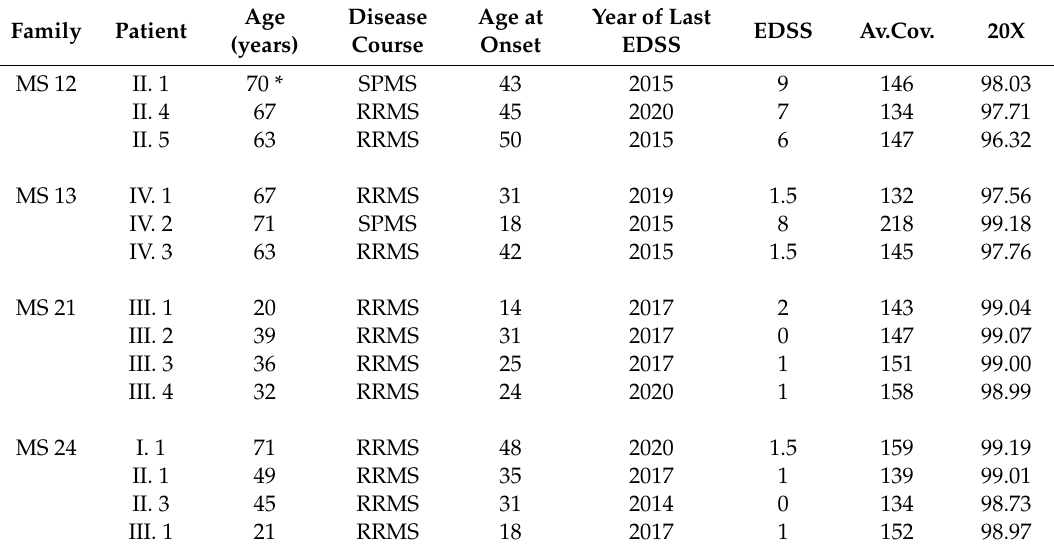
Table 1. Patient